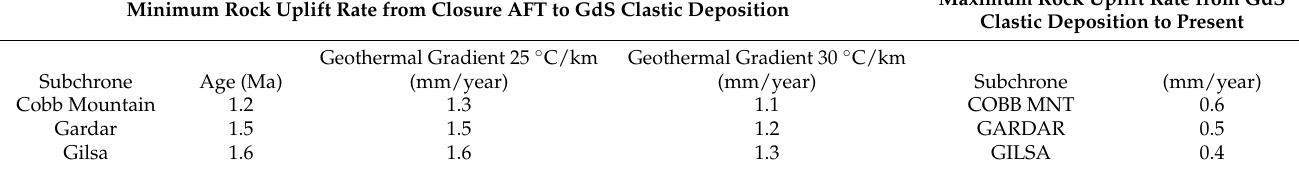
Table 3. Rock uplift rates of Mt. Corchia constrained by AFTs (from [5]) and the magnetostratigraphic dating. Minimum Rock Uplift Rate from Closure AFT to GdS Clastic Deposition